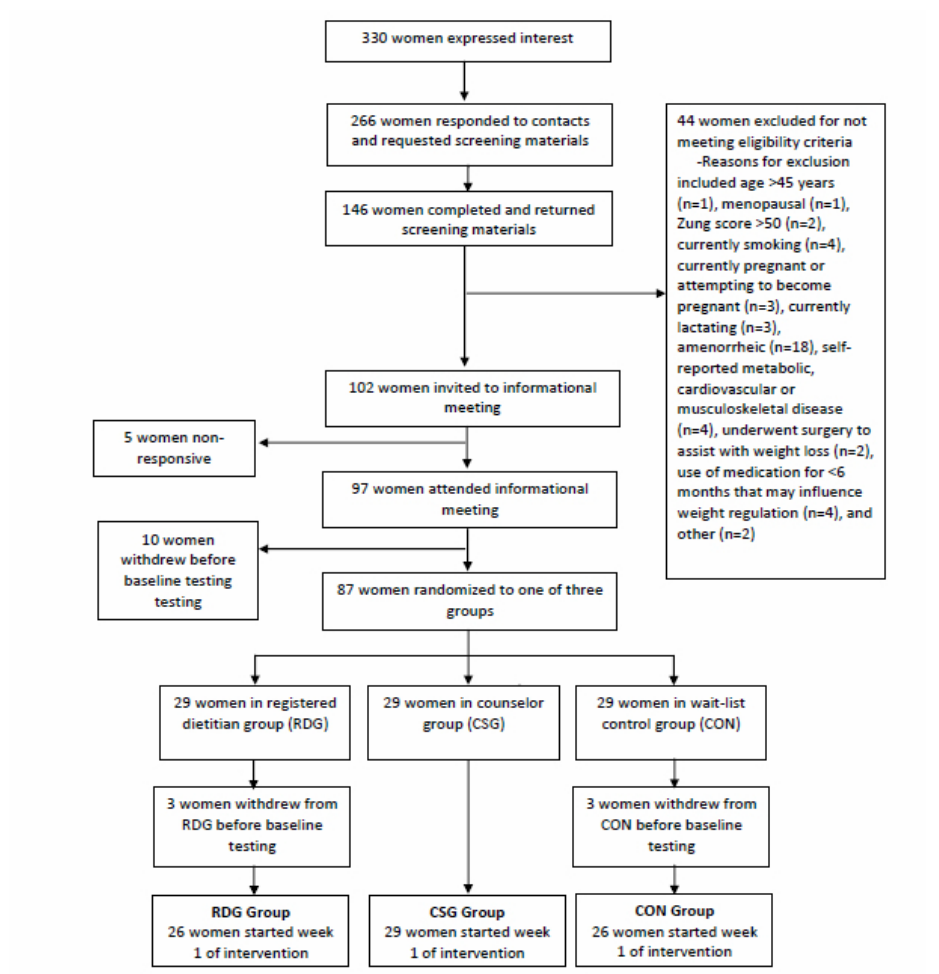
Figure 1. Diagram of recruitment, enrollment and randomization of participants in a study examining weight gain prevention in young adult and midlife